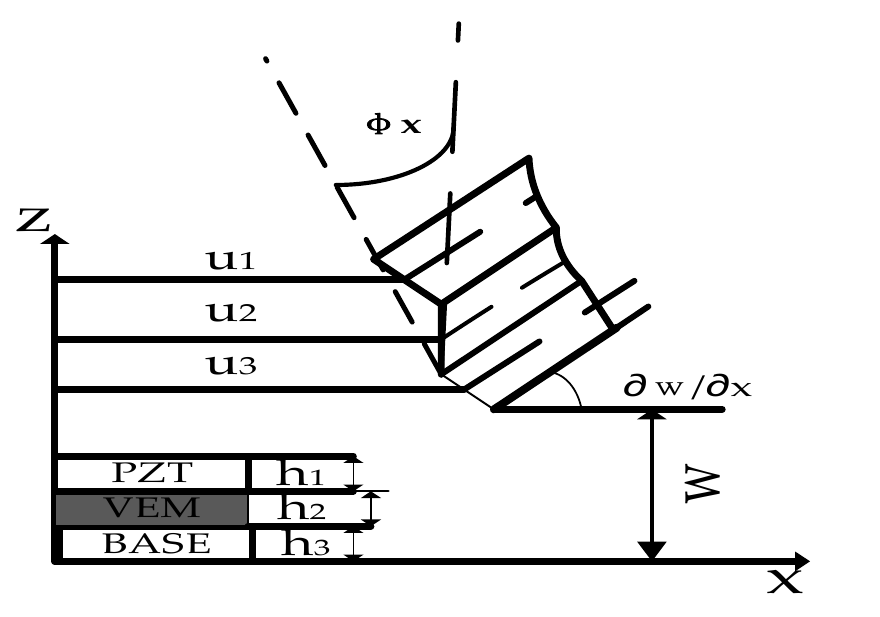
Figure 4. Plate deformation displacement diagram.